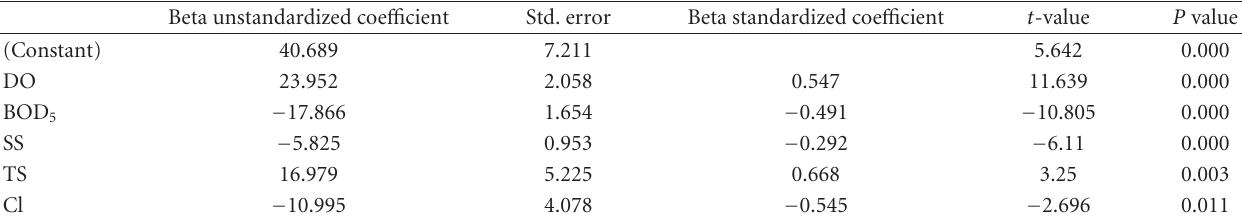
Table 6: Estimates of coe ffi cients of the model (wet season) of parameters in